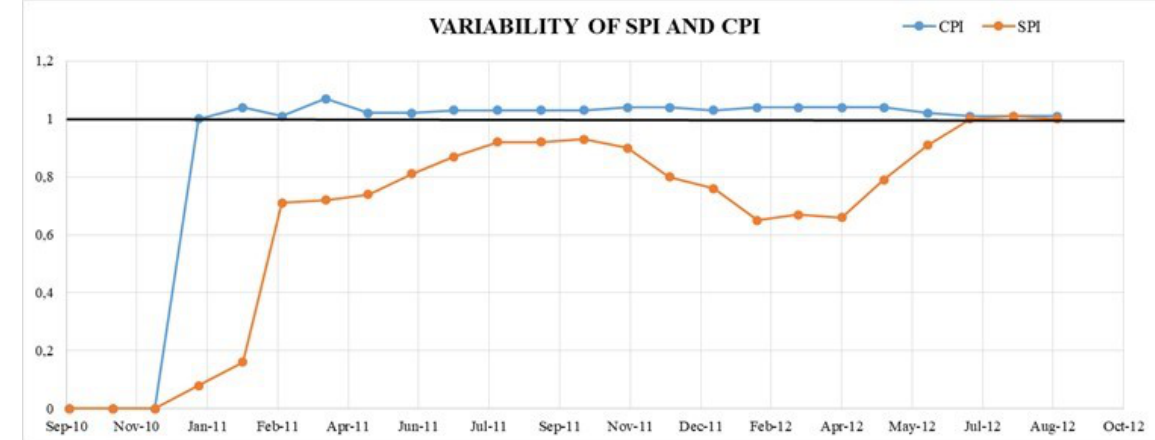
Figure 3: Variability of SPI and CPI [authors’ data]